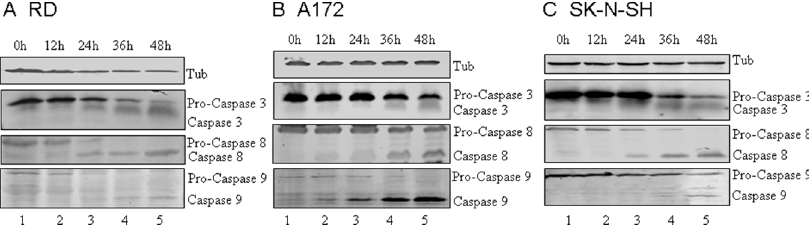
Figure 5. CA16 infection results in pro-caspase cleavage in neural and non-neural cell lines. Neural and non-neural cell lines were infected with CA16 SHZH05 virus at the MOI of 0.2 and harvested at 0 h, 12 h, 24 h, 36 h and 48 h. The cells were lysed and analyzed via immunoblotting against caspases 3, 8 and 9 and tubulin where indicated. (A) RD cells, (B) A172 cells, (C) SK-N-SH cells.